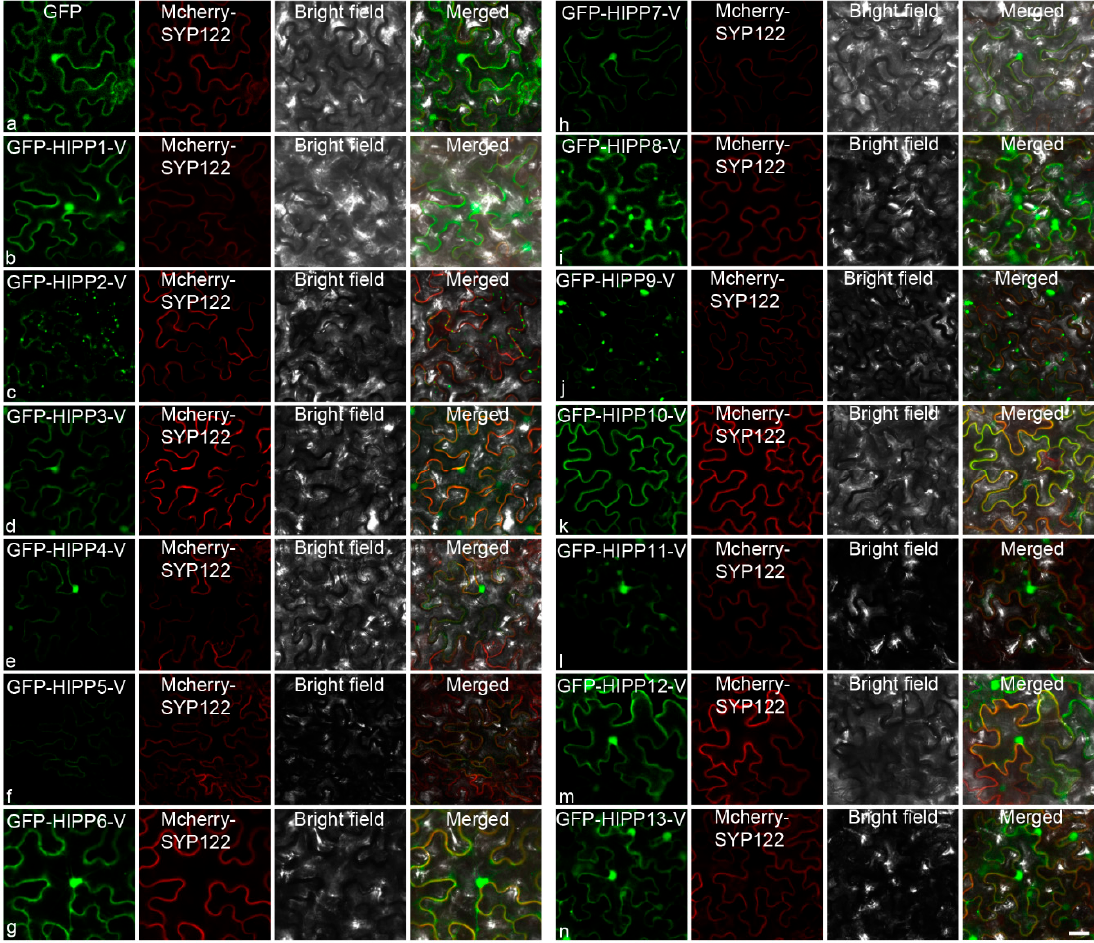
Figure 5. Subcellular localization of HIPPs in the epidermal cells of Nicotiana benthamiana : subcellular localization of GFP ( a ), GFP-HIPP1-V ( b ), GFP-HIPP2-V ( c ), GFP-HIPP3-V ( d ), GFP-HIPP4-V ( e ), GFP-HIPP5-V ( f ), GFP-HIPP6-V ( g ), GFP-HIPP7-V ( h ), GFP-HIPP8-V ( i ), GFP-HIPP9-V ( j ), GFP-HIPP10-V ( k ), GFP-HIPP11-V ( l ), GFP-HIPP12-V ( m ), and GFP-HIPP13-V ( n ). GFP was used as the control. The localization of mCherry-SYP122 is shown in red, and the localization of GFP and its fusion proteins are shown in green. Scale bar = 10 μ m.